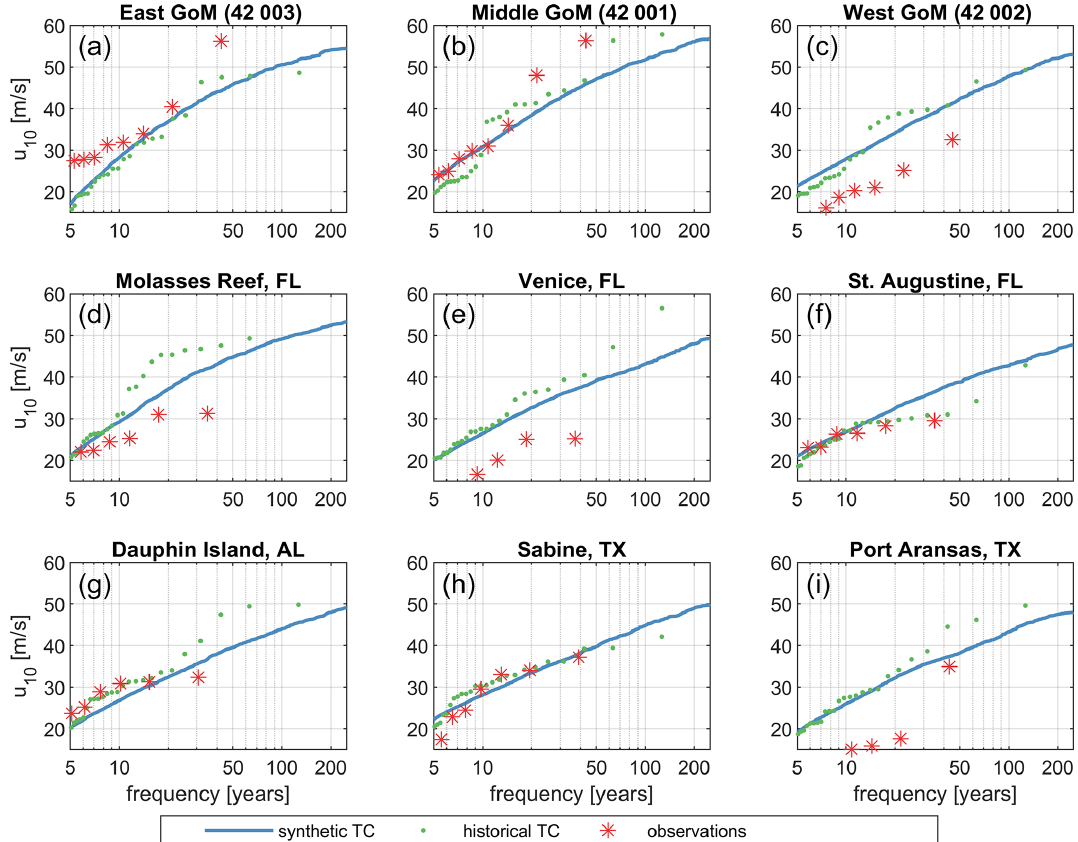
Figure 11. Observed and TCWiSE-computed TC extreme wind speeds for different return periods. Red stars are observed events from NDBC and NOAA wave buoys. Green dots are historical TCs based on BTD and the Holland wind profile, and blue line are synthetic modeled events based on synthetic tracks and the Holland wind profile. All wind speeds are in meters per second, 10min averaged and determined at a 10m